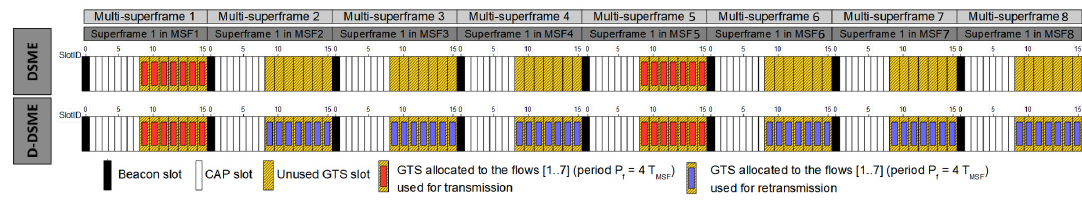
Figure 3. Example using